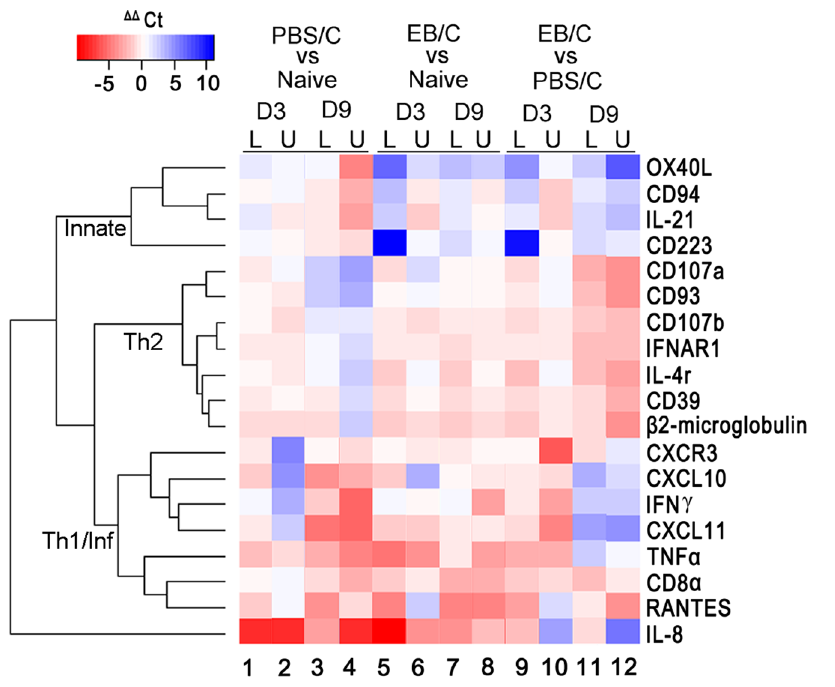
Fig. 5. Comparative Heatmap Depiction of Differential Gene Expression using RT-PCR array screening. Three groups of guinea pigs were used for the comparative study: non vaccinated and non challenged (naı¨ve), mock vaccinated but challenged (PBS/C), and C. caviae EB vaccinated and challenged (EB/C) groups. Each group contained three animals. The tissues (upper and lower genital tracts, U and L, respectively) from the respective groups of animals were collected at days 3 and 9 after challenge. Red shading indicates an increase in expression, while blue shading indicates suppression of expression, of the gene indicated on the right side of the panel. Lighter shades including white indicate similar levels of expression. Functional gene clustering is indicated by the brackets on the left showing 3 major groups consisting of innate, Th2 and Th1/inflammatory related